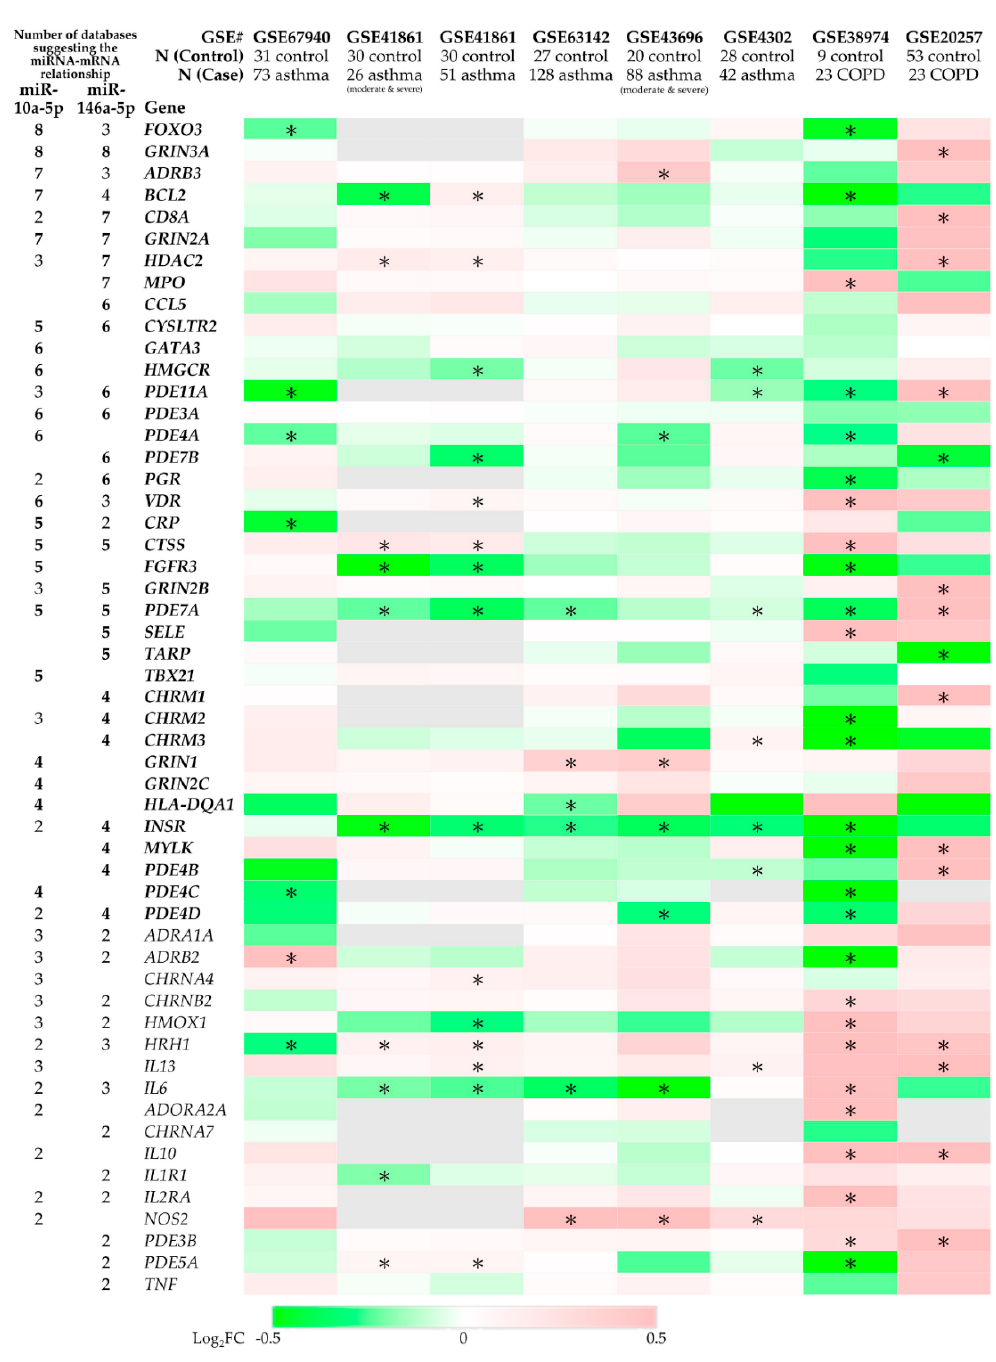
Figure 4. The expression levels of predicted microRNA targets in asthma/chronic obstructive pulmonary disease (COPD) bronchial epithelial cells. The data from the Gene Expression Omnibus (GEO) database were analyzed with GEO2R. The log 2 -fold change (log 2 FC) between two groups (asthma/COPD vs. control) were shown. * The p value adjusted with method by Benjamini and Hochberg (false discovery rate) (adj. p ) < 0.25. The detailed information is presented in Table A2 of Appendix A.